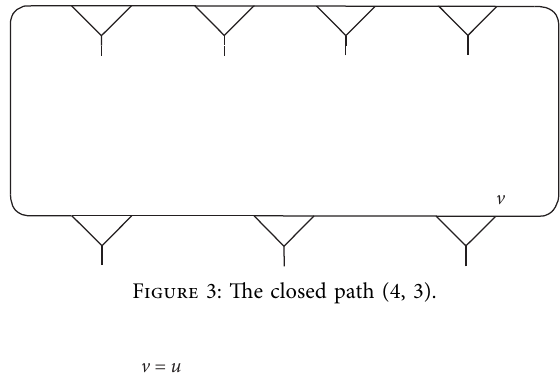
Figure 3: The closed path (4, 3).